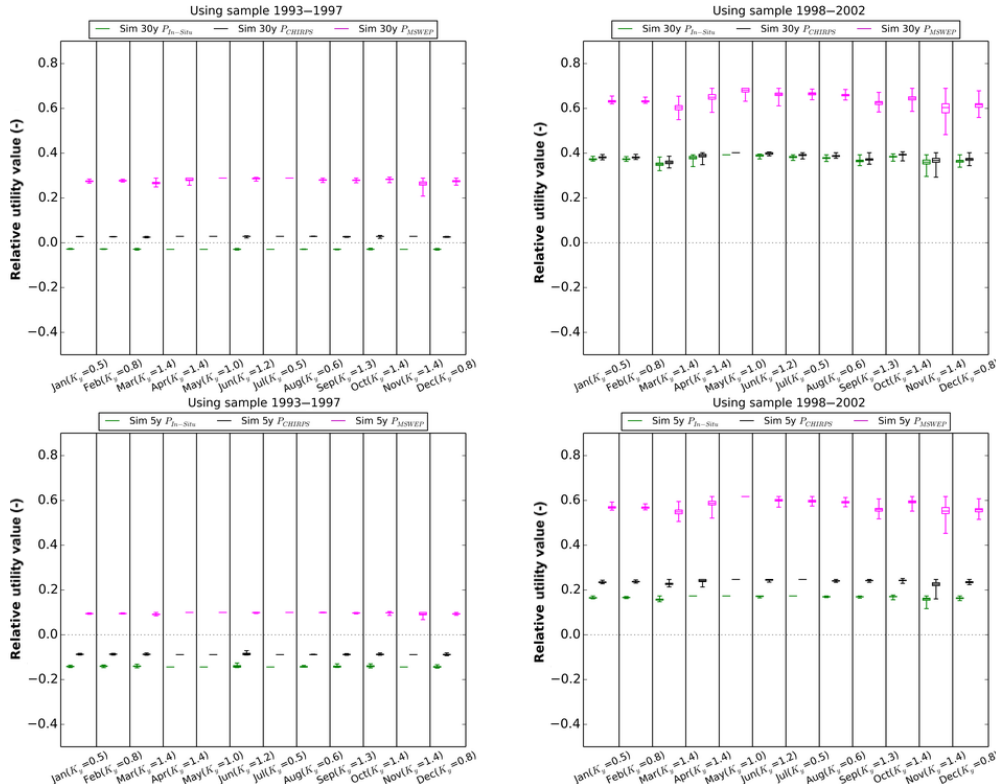
Figure 10. Relative utility value using simulated river discharge of 30 and 5 years for water scarcity happening independently in any one month. K y is the sensitivity of the crop to water deficit. Boxplots show the median, interquartile range and minimum–maximum